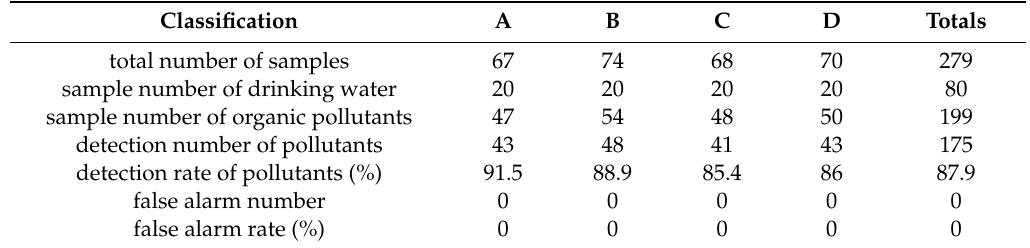
Table 6. Qualitative discrimination results based on the improved algorithm.